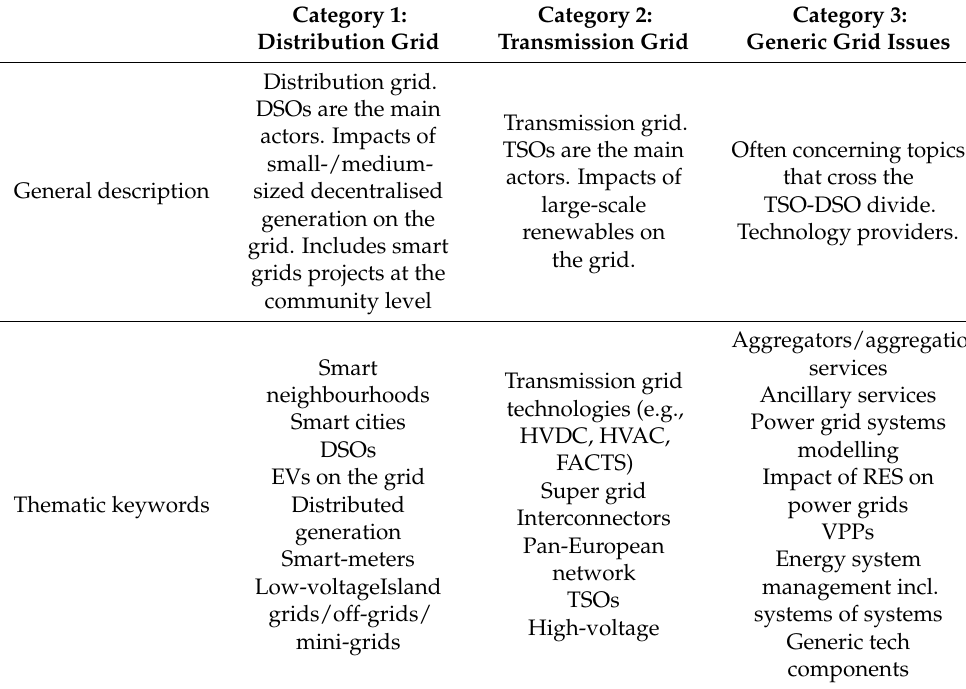
Table 1. Coding system for the three categories of electricity grid technology and